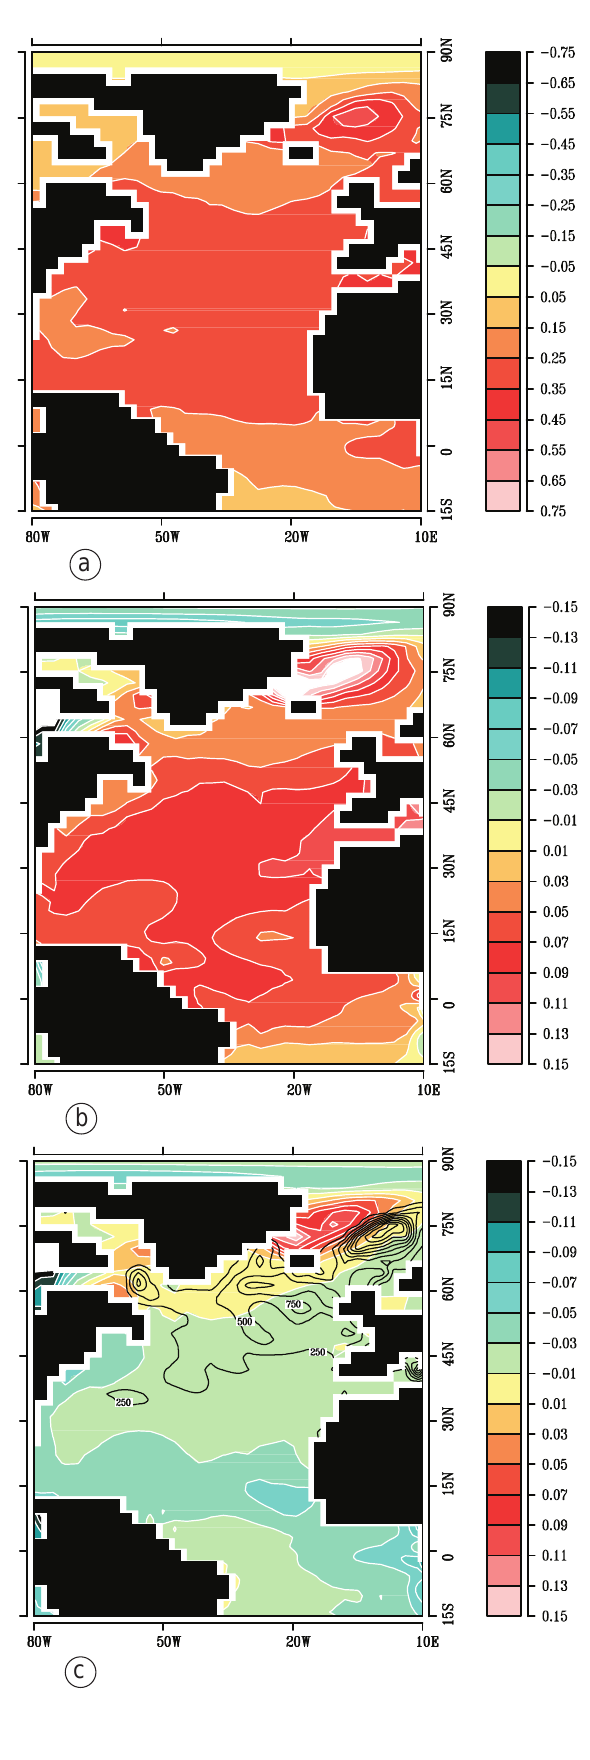
Fig. 3a-c. Centennial linear trends of selected quan- tities in the North Atlantic obtained from the transient greenhouse warming simulation and com- puted over the period 2000-2100. a) Trend in SST ( ° C/decade); b) trend in sea surface salinity (psu/ decade); c) trend in surface density [kg/ (m 3 *decade)]. The depth of the convection (m) simulated for the month of February in the control integration is shown as contours (contour interval is 250 m). The two main convection regions in the Labrador and GIN (Greenland-Iceland-Norwegian) Seas are simulated realistically by the model. No significant change in the density is simulated in these